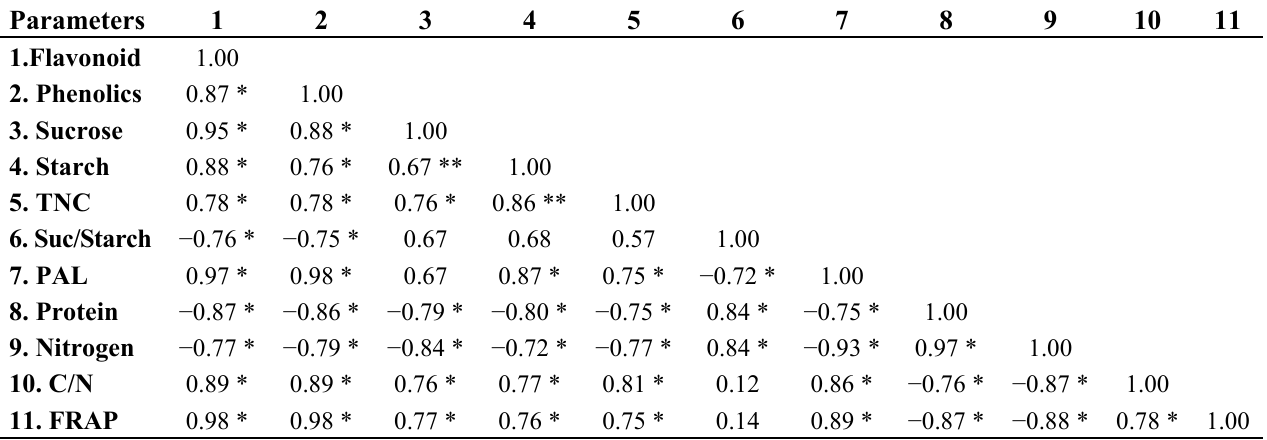
Table 2. Correlation among the measured parameters in the